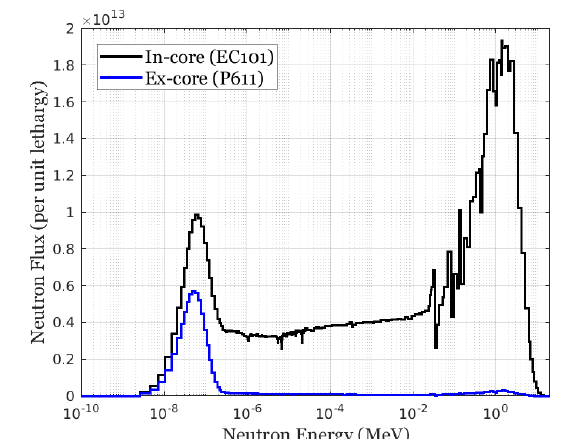
Fig. 6. Neutron spectrum distributions at the core and reflector irradiation positions.